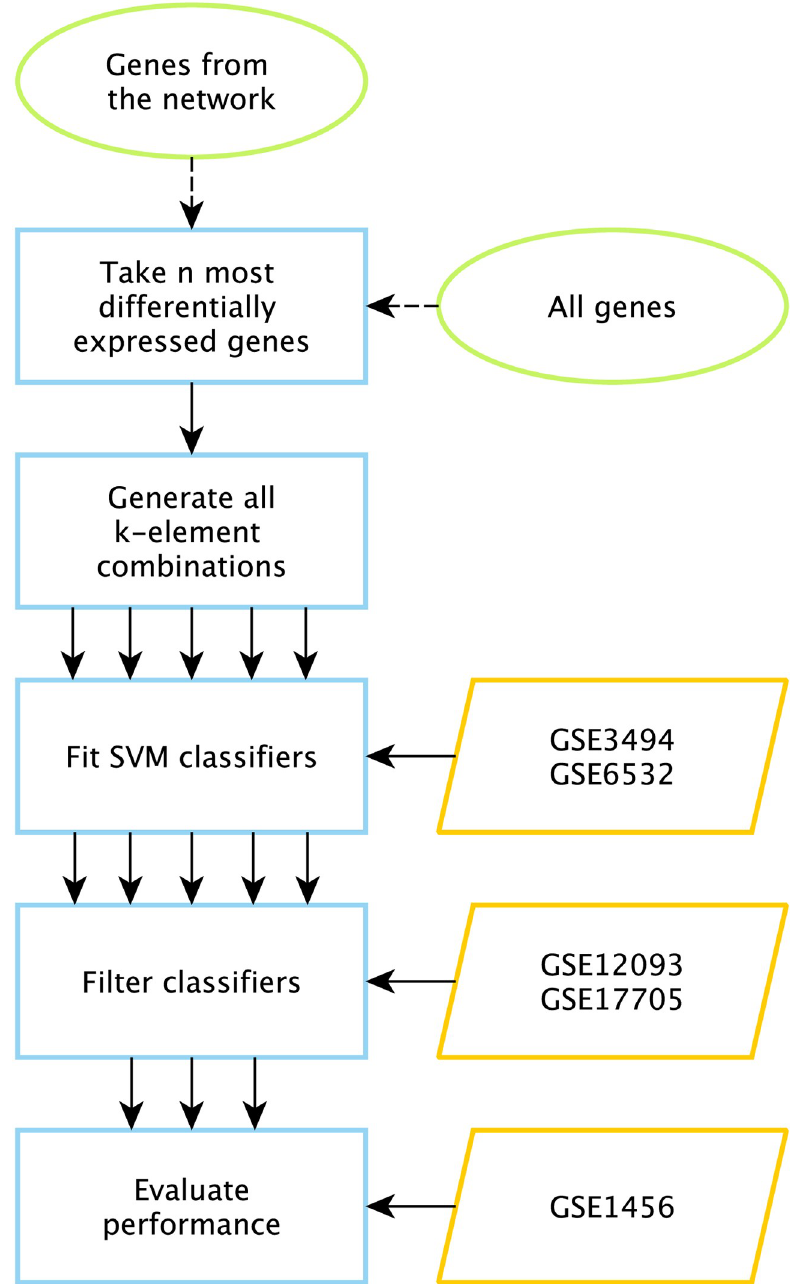
Fig 7. Classifier construction pipeline. Green-framed ellipses denote lists of input genes (pipeline can be evaluated in two ways), blue-framed rectangles represent processes, orange-shaped parallelograms represent input data.